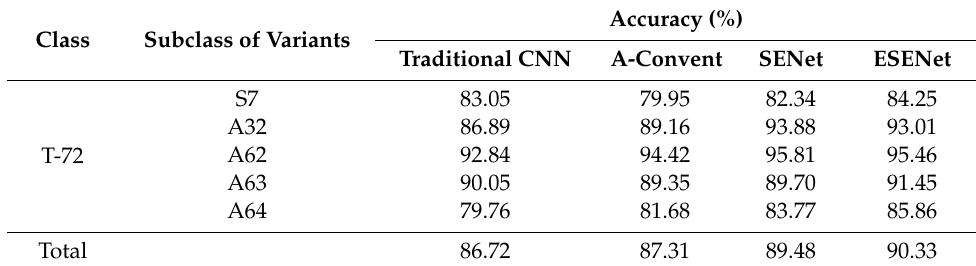
Table 9. Recognition accuracy comparison under EOC2 (configuration variants).